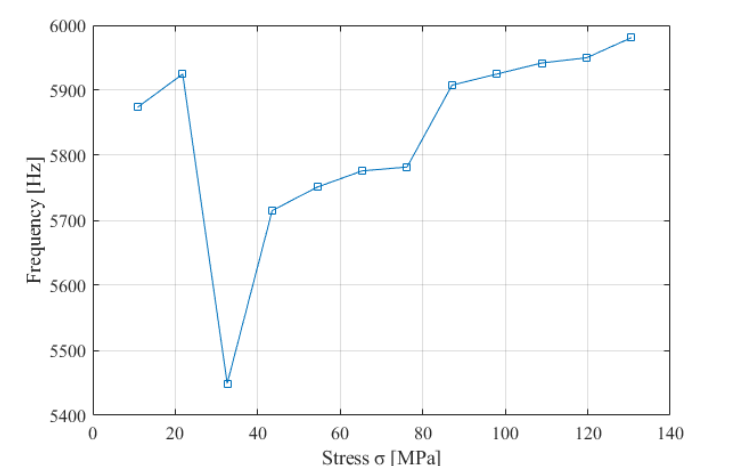
Figure 7. Graph of frequency dependence versus the given load without filtering.